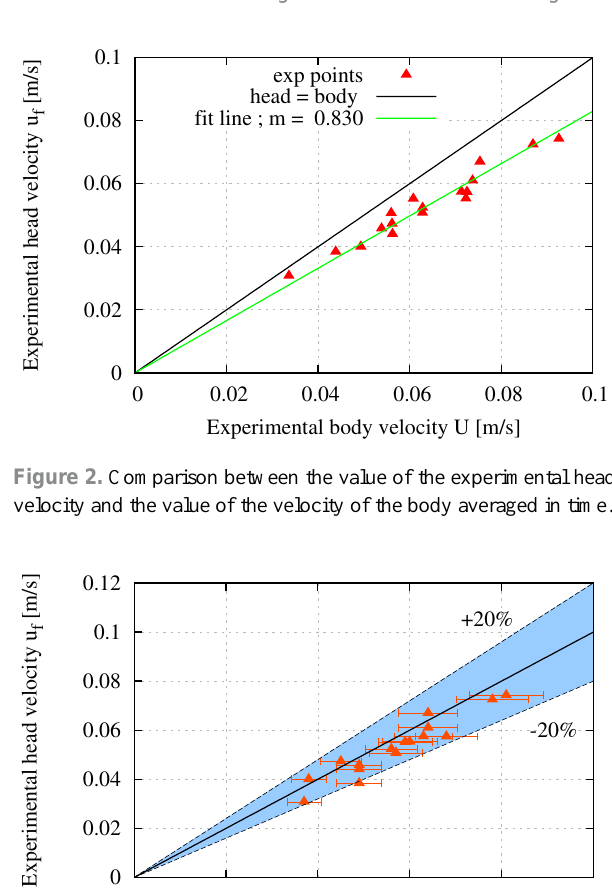
Figure 5. Velocity profiles measured in experiment S4 (Saline flow, q 0 = 0 . 0034 m 2 / s, ∆ ρ/ρ = 0 . 6 %). (a) Spatial distribution of longi- tudinal velocity and flow interface (blue line) measured during the experiment. The interface height obtained from the corresponding velocity profile (blue dots) employing equations (1) and (2) is also reported. (b) Dimensionless velocity profiles. 332 5 represents the interface between the current and the ambi- 333